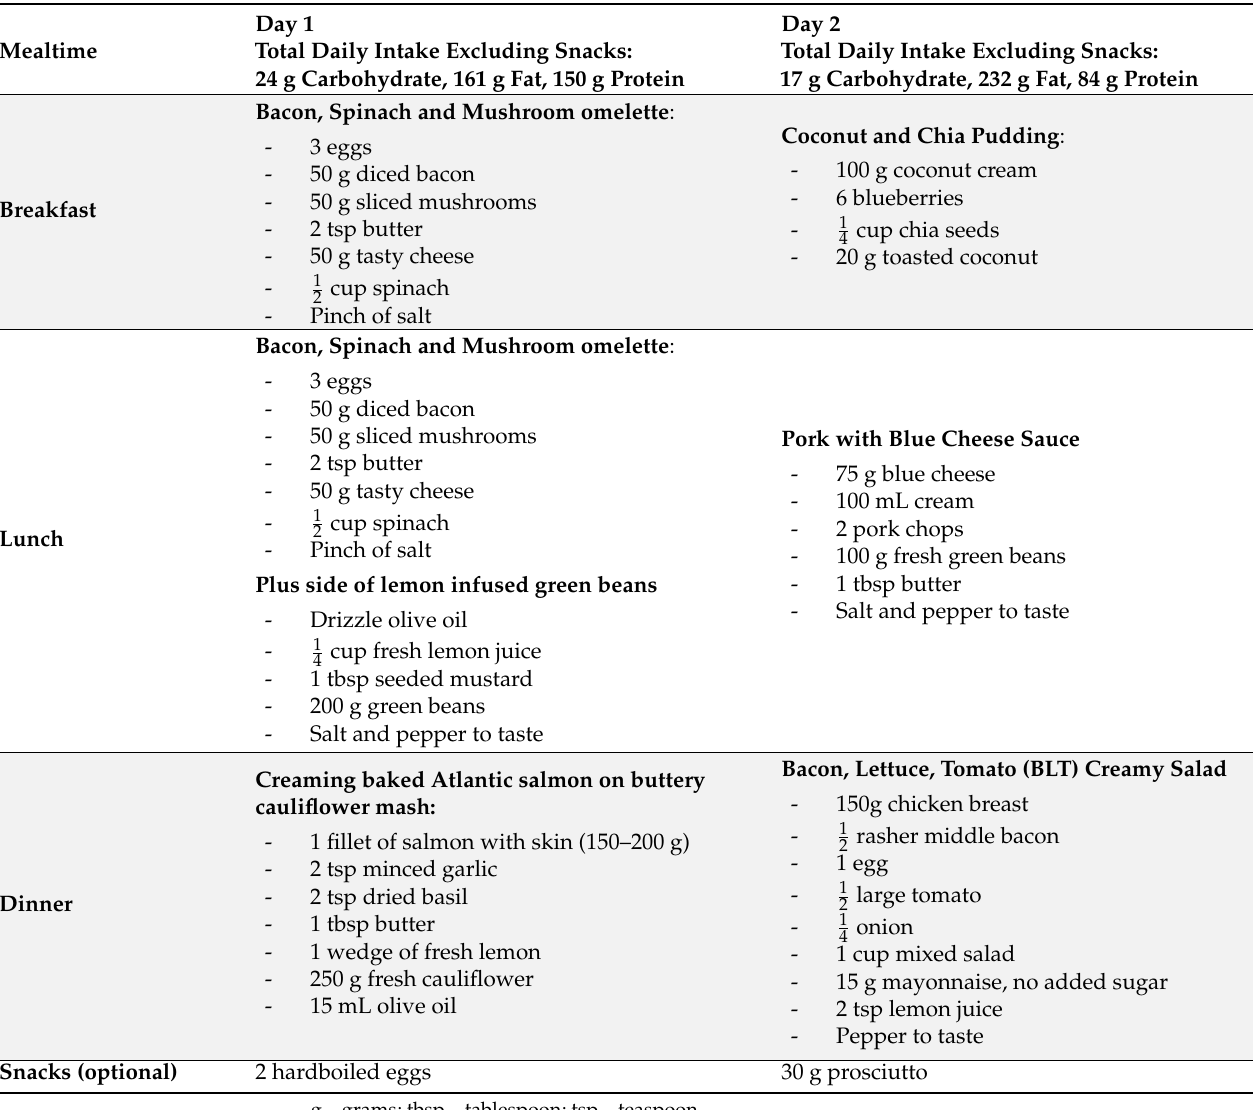
Table 1. Two-day sample meal plan for the Diversa Health Low Carbohydrate Diet eating